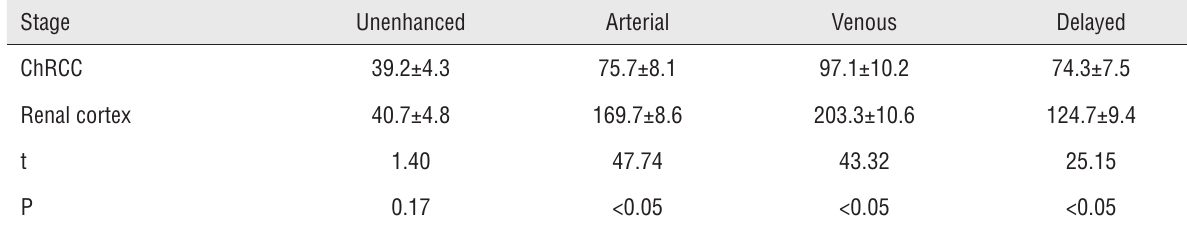
Table 2 - Mean attenuation values (HU) of tumor and normal renal cortex at 4 various stages.